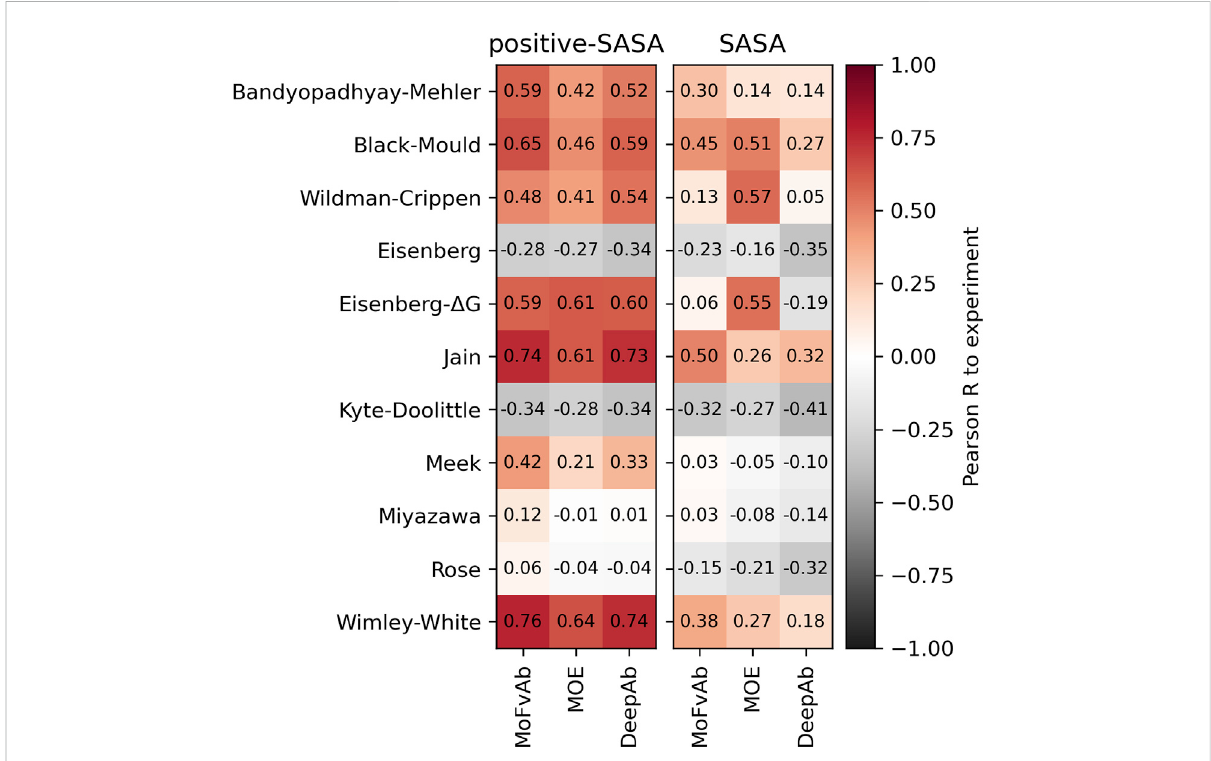
FIGURE 4 Performance of different homology modelling packages on the Roche-127 set in combination with the positive-SASA (left panel) and SASA (right panel) scores as well as different hydrophobicity scales. The Pearson correlation was calculated with respect to the HIC retention times of the Roche-127